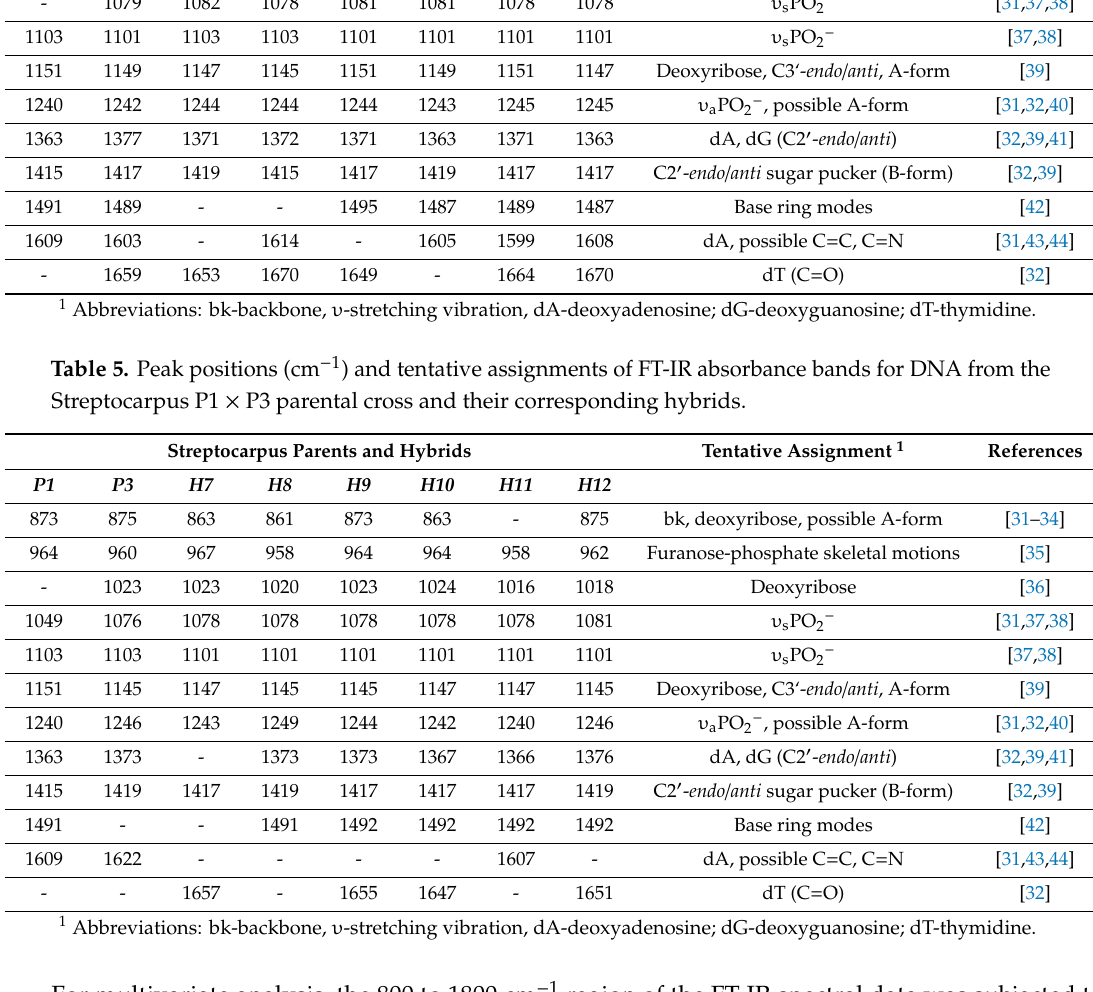
1 Abbreviations: bk-backbone, υ -stretching vibration, dA-deoxyadenosine; dG-deoxyguanosine; dT-thymidine. − 1 For multivariate analysis, the 800 to 1800 cm region of the FT-IR spectral data was subjected to hierarchical cluster analysis (HCA) and principal component analysis (PCA). The HCA